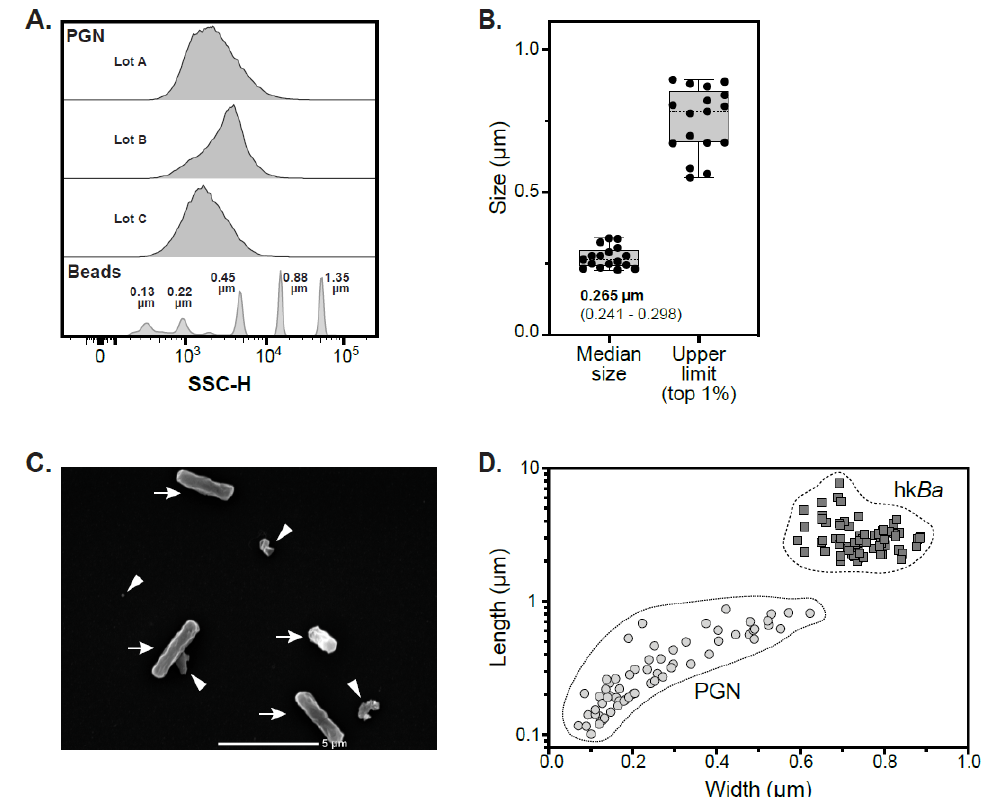
Figure 1. Size quantification of PGN macromolecules purified from the bacterial cell wall by nanoscale flow cytometry and scanning electron microscopy (SEM). ( A ) Histogram overlay of SSC measurements from 3 independent PGN lots depicting broad particle size distribution. For comparison, median SSC for nanobeads of known sizes used to calibrate the cytometry acquisition and generate the sizing standard curve is shown at the bottom. ( B ) Floating bar representation of sizes of PGN macromolecules from 17 independent purification lots depicting the median size (left) and the upper range (top 1%, right) of PGN particles. The estimated median and interquartile range (IQR) of PGN particles is noted in the inset. The lower limit of PGN particles (not shown) was below the lower limit of quantitation (see details in text). ( C ) Scanning electron micrograph of PGN particles (arrowheads) and heat-killed Bacillus anthracis (arrows). ( D ) Distribution of PGN and Bacillus anthracis (hk Ba ) particles depicted based on orthogonal measurement of individual particles. For clarity, length is shown on a logarithmic scale while width is shown on a linear scale. Single lot, individual PGN particles ( n = 64, circles) and hk Ba ( n = 73, squares) are shown.